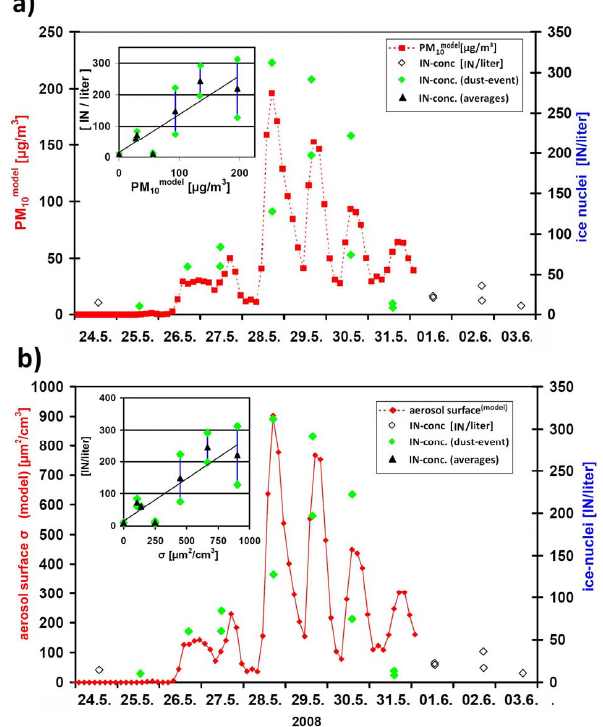
Fig. 8. (a) PM model mass concentration at the Taunus Observatory 10 Figure 8: calculated by the DREAM model and number concentration of ice nuclei (diamonds, #/l, 18 samples) measured at Taunus Observatory as a function of time; Inset: Linear regression of IN number concen- tration during the dust event (triangles) against PM model mass con- 10 centration: y [IN/l] = 1.23 · [PM model , µg/m 3 ] + 14.76; R = 0 . 888. 10 Triangles ( n = 7) are means of those individual IN samples (green diamonds, n = 12) which were taken within a period of one hour. (b) Same as (a) but for aerosol surface concentration ( σ ) of model size bins 1–7. Inset: Linear regression of IN number concentration during the dust event (triangles) against PM model surface concen- 10 tration: y [IN/l] = 0 . 26 · σ [µm 2 /cm 3 ] +14.80, R = 0 . 919. Trian- gles ( n = 7) are means of individual IN samples (green diamonds, n = 12) taken within a period of one